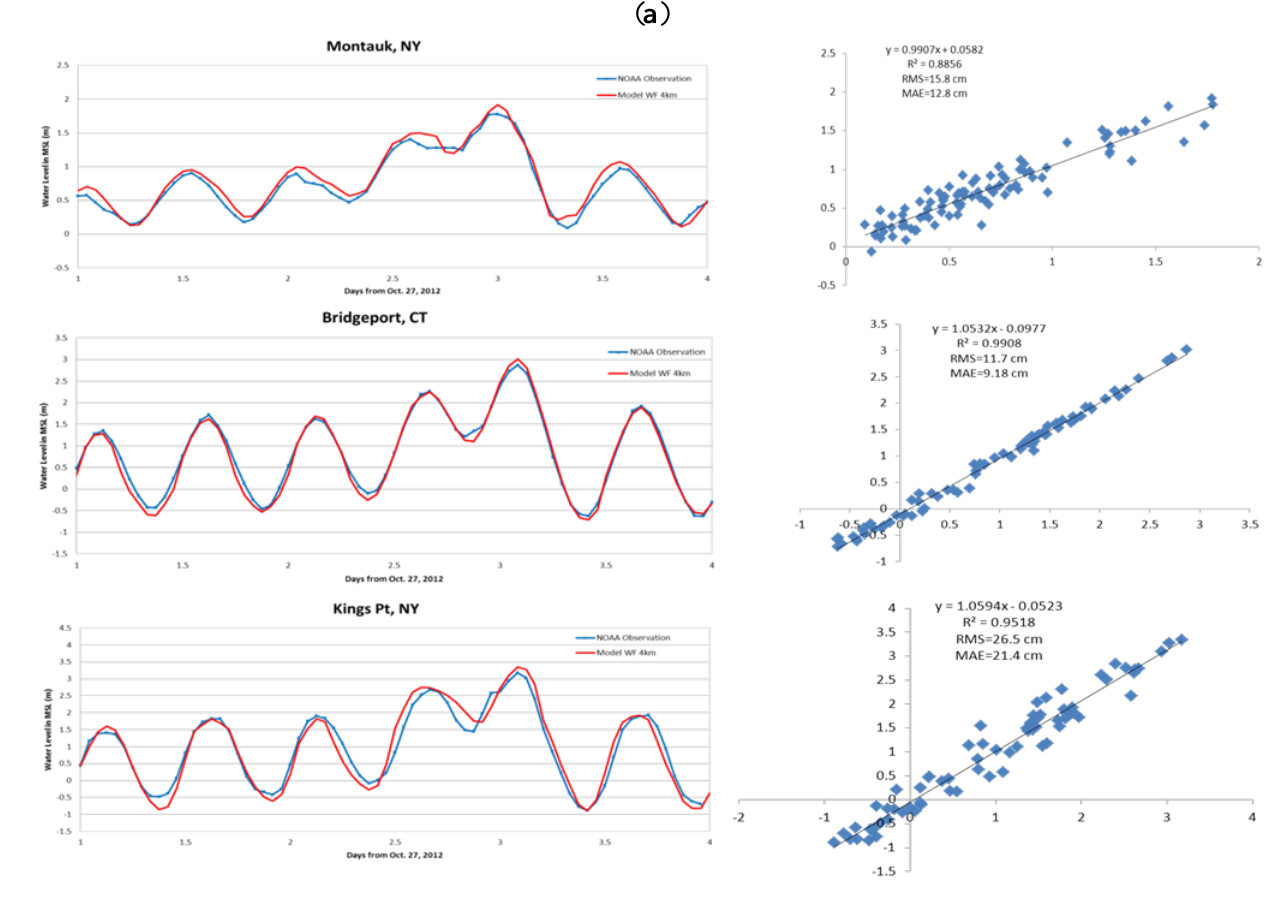
Figure 2. ( a ) Storm tide model results and data comparison for stations in Long Island Sound. Time series (left) and the statistical measures (right); ( b ) Storm tide model results and data comparison for stations near New York Harbor and Atlantic City, NJ, USA. Time series (left) and the statistical measures (right); ( c ) Storm tide model results and data comparison for stations in Delaware, Virginia and North Carolina, USA. Time series (left) and the statistical measures (right). The measurement errors are visible on day 3 at Lewes, DE, USA . ( a